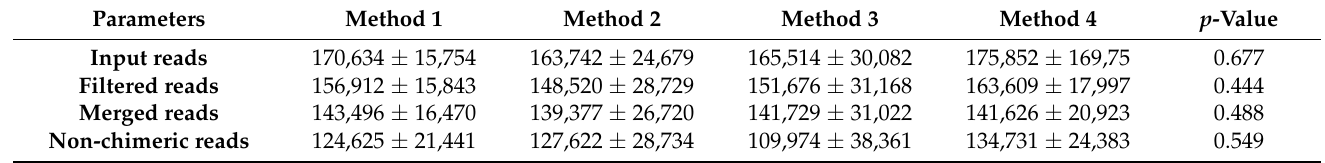
Table 2. Output read statistics of filtering and trimming using dada2 did not differ among the commercial DNA extrac- tion method. Cloacal samples, positive, and negative controls were processed in the same way. Data are presented as median ± inter-quartile range. There were no significant differences between DNA extraction methods ( p > 0.05, Kruskal– Wallis